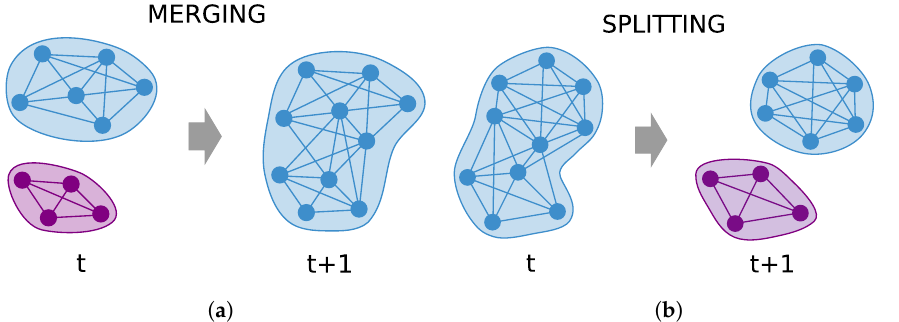
Figure 2. Hypermutation operator. ( a ) A subset of nodes from community c h will be merged to an existing community c h (cid:48) . ( b ) A subset of nodes from community c h will be split to create a new community c h (cid:48)